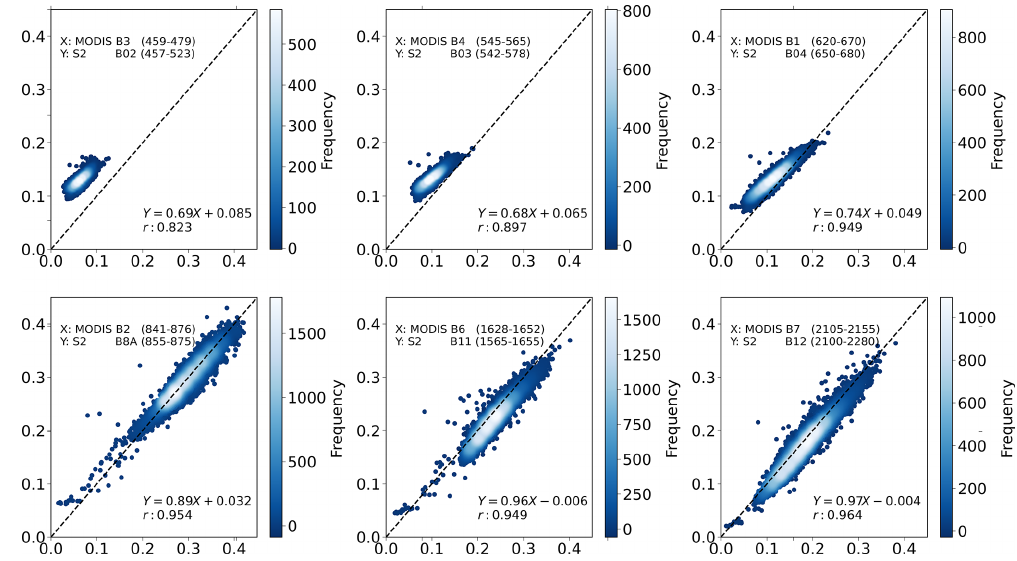
Figure E3. Per-band comparison between the MCD43-simulated surface reflectance r c ((cid:51)(m)) and ˆ y(G c ) at six MODIS bands.